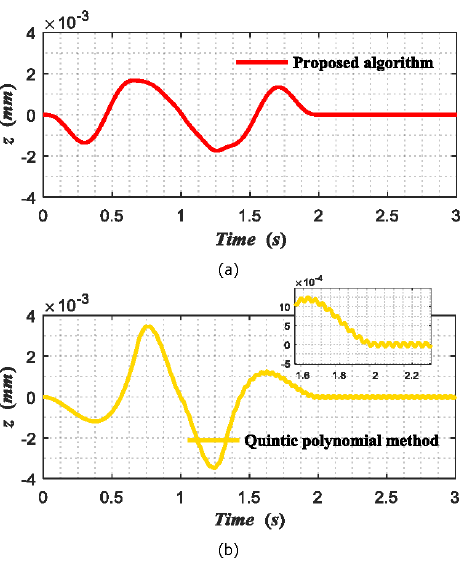
Figure 8. Vibrations of the mass–spring system of Fig. 6: (a) quin- tic polynomial algorithm, (b) proposed algorithm.